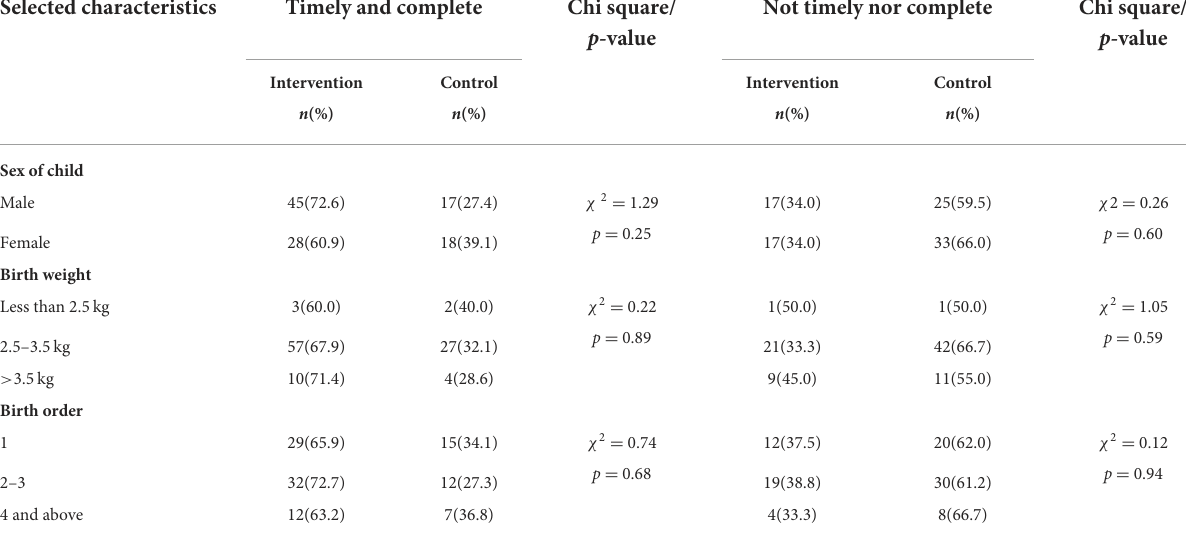
TABLE 5 Relationship between infant characteristics and overall timeliness and completion of vaccination among infants in urban slum communities in